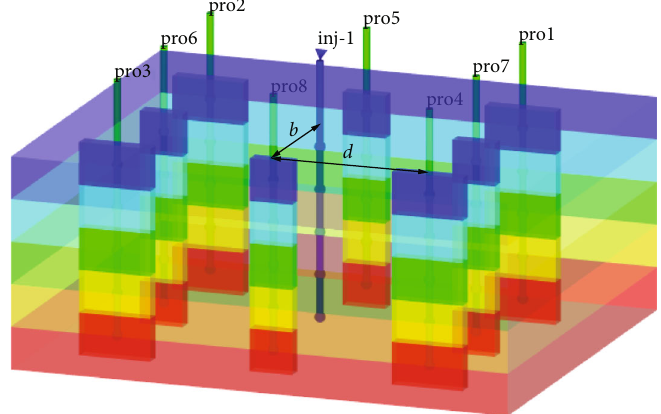
Figure 4: Three-dimensional reservoir model of inverted 9-spot well